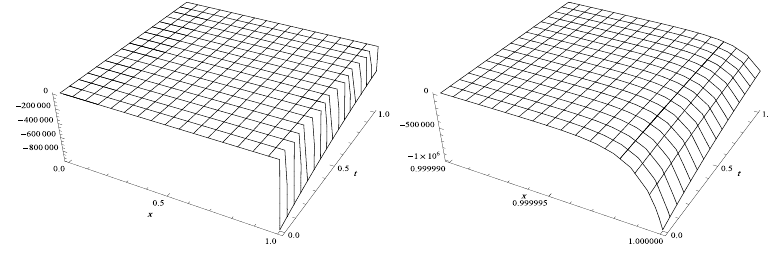
Figure 7. Derivative of the solution relative to x ( ∂ x y ( x,t )) throughout region D for Examples 1, 2, 3, with ε = 10 − 6 (Left: derivative of the solution; Right: boundary layer